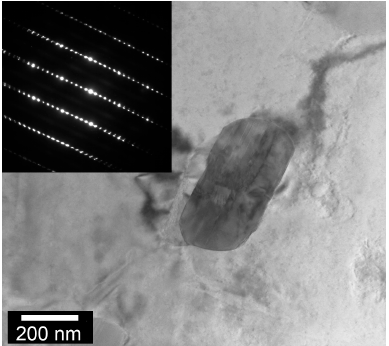
Figure 3. Typical bright filed TEM image and the selected area diffraction pattern illustrating the grain with the long-period stacking ordered (LPSO) phase in the α -Mg matrix of the alloy WZ21.